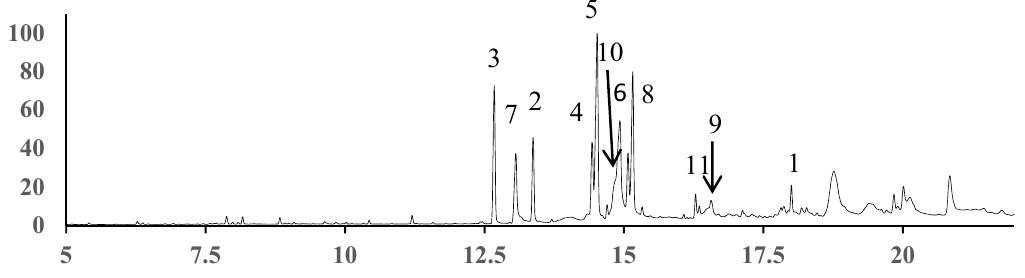
Table 4. FAs profile of the pollen oil by GC-MS analysis.